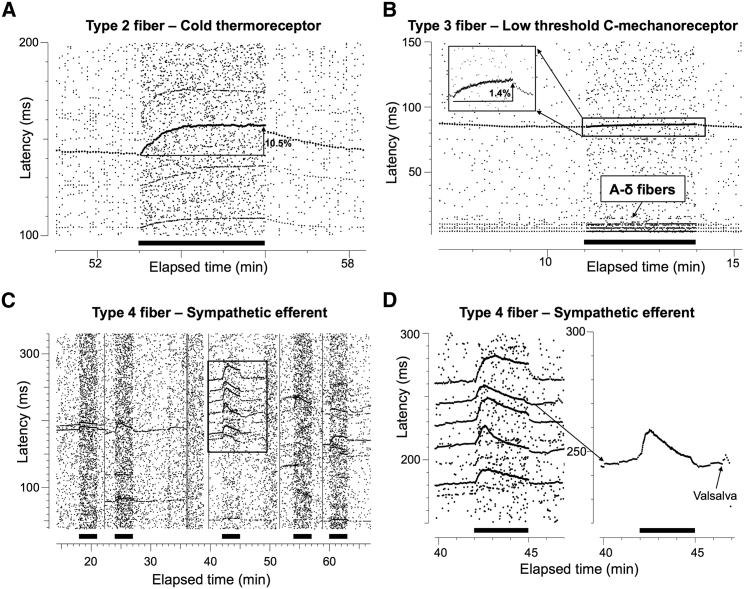
Microneurographic Raster Plots Illustrating Absence of ADS Profiles Compatible with C-Nociceptors(A–D) Several characteristic profiles of activity-dependent slowing were identified in all three patients compatible with cold thermoreceptors (A), low threshold C-mechanoreceptors (B, longer latency), Aδ fibers (B, shorter latencies), and several sympathetic units (C and D). However, no ADS profiles characteristic of C-nociceptors could be identified.(C) 5 different intraneural recording sites separated by straight vertical lines in which only profiles of ADS compatible with sympathetic units could be recorded with an initial slowing followed by relative speeding up of conduction velocity during a 2 Hz stimulation period for 3 min (marked by filled bars).(D) Magnified view of the square of the third intraneural recording site in (C). Right shows an enlarged view of a sympathetic unit at initial latency of 240 ms responding to a Valsalva maneuver with a burst of activity.Nomenclature of units follows that of Serra et al., 1999, Serra et al., 2004.